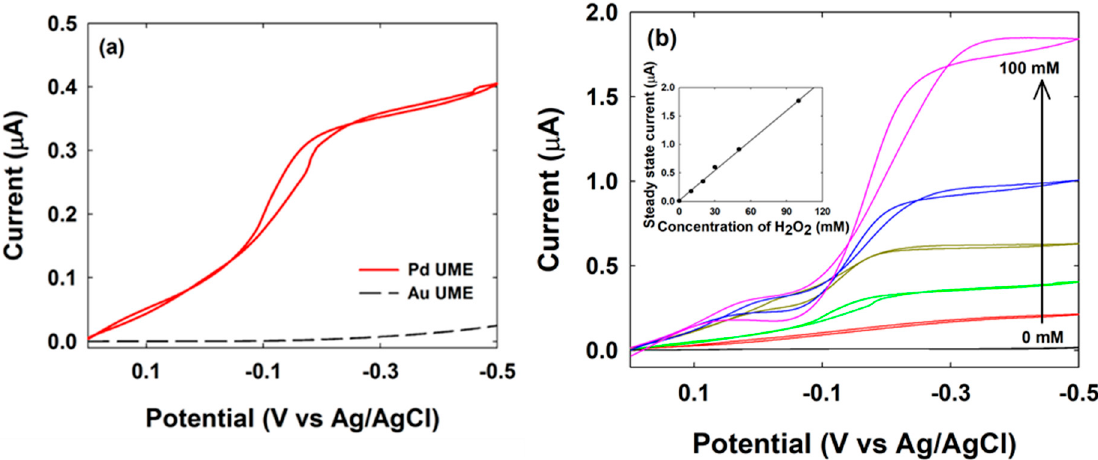
Figure 2. Cyclic voltammograms of hydrogen peroxide reduction reaction at: ( a ) Au (black dashed) or Pd (red solid) ultramicroelectrode (UME) (radius 6.35 and 10 µm, respectively) in a 0.1 M phosphate buffer (PB) solution (pH 6.8) containing 20 mM H 2 O 2 ; ( b ) Pd UME in 0.1 M PB solution (pH 6.8) containing 0, 10, 20, 30, 50, and 100 mM H 2 O 2 . Scan rate was 100 mV/s.